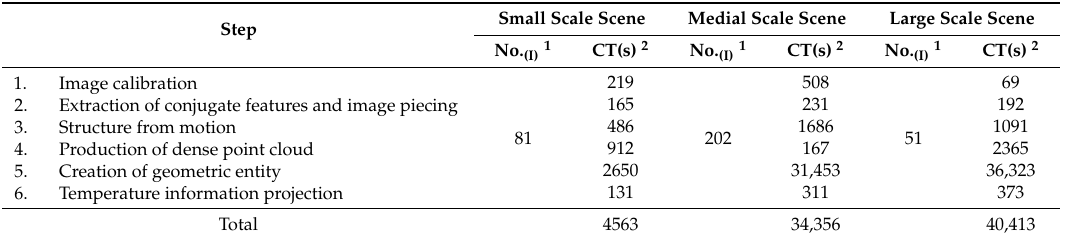
1 Number of images; 2 Computational